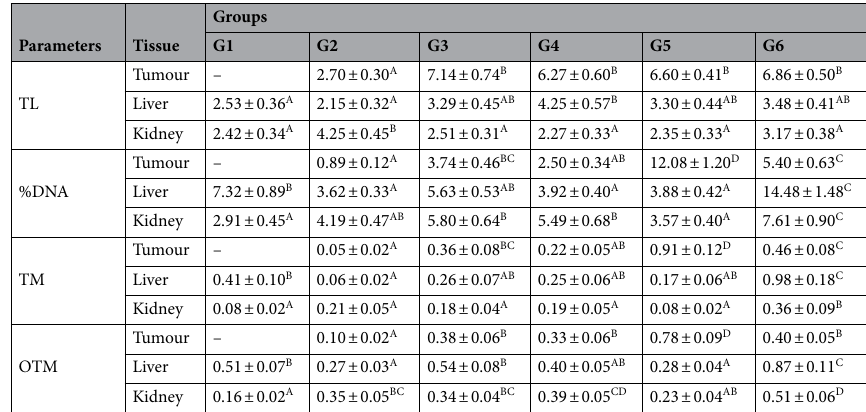
Table 3. Tail length (TL), %DNA, tail moment (TM) and olive tail moment (OTM) in the tumor, liver and kidney tissues of normal negative control group (G1), tumor control groups (G2), doxorubicin-treated group (G3) and groups treated with 100, 200 or 400 mg/kg of PSO nano-emulsion (G4, G5, G6) respectively. Data is displayed as mean ± standard error. In the same row, means marked with the same superscript letters are insignificantly ( P > 0.05) different, whereas those marked with different ones are significantly ( P < 0.05) different.